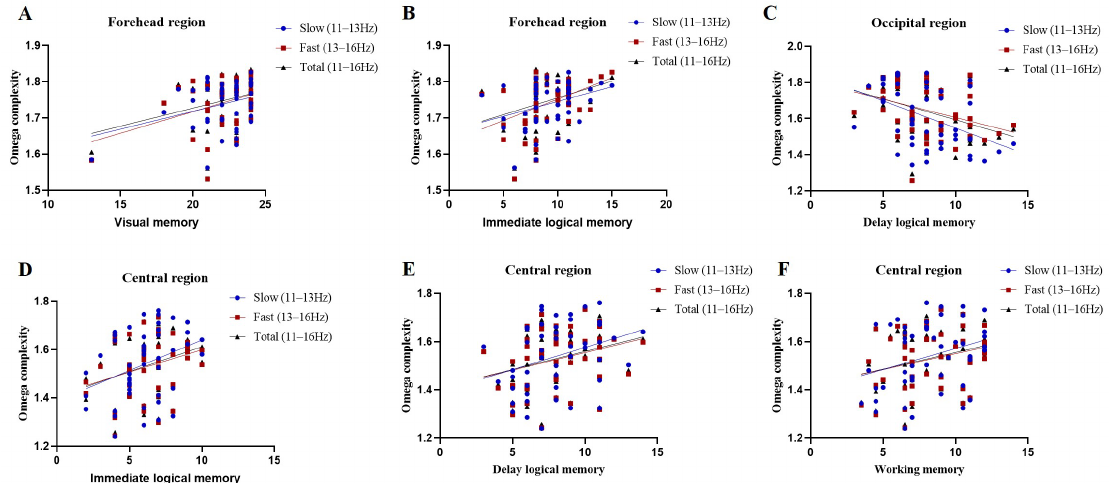
Figure 4. Correlation results of sleep spindle omega complexity and memory function; ( A ) the relationship Omega with visual memory; ( B ) the relationship Omega with immediate logical memory; ( C ) the relationship Omega with delayed logical memory; ( D ) the relationship Omega with immediate logical memory; ( E ) the relationship Omega with i delayed logical memory; ( F ) the relationship Omega with working memory.